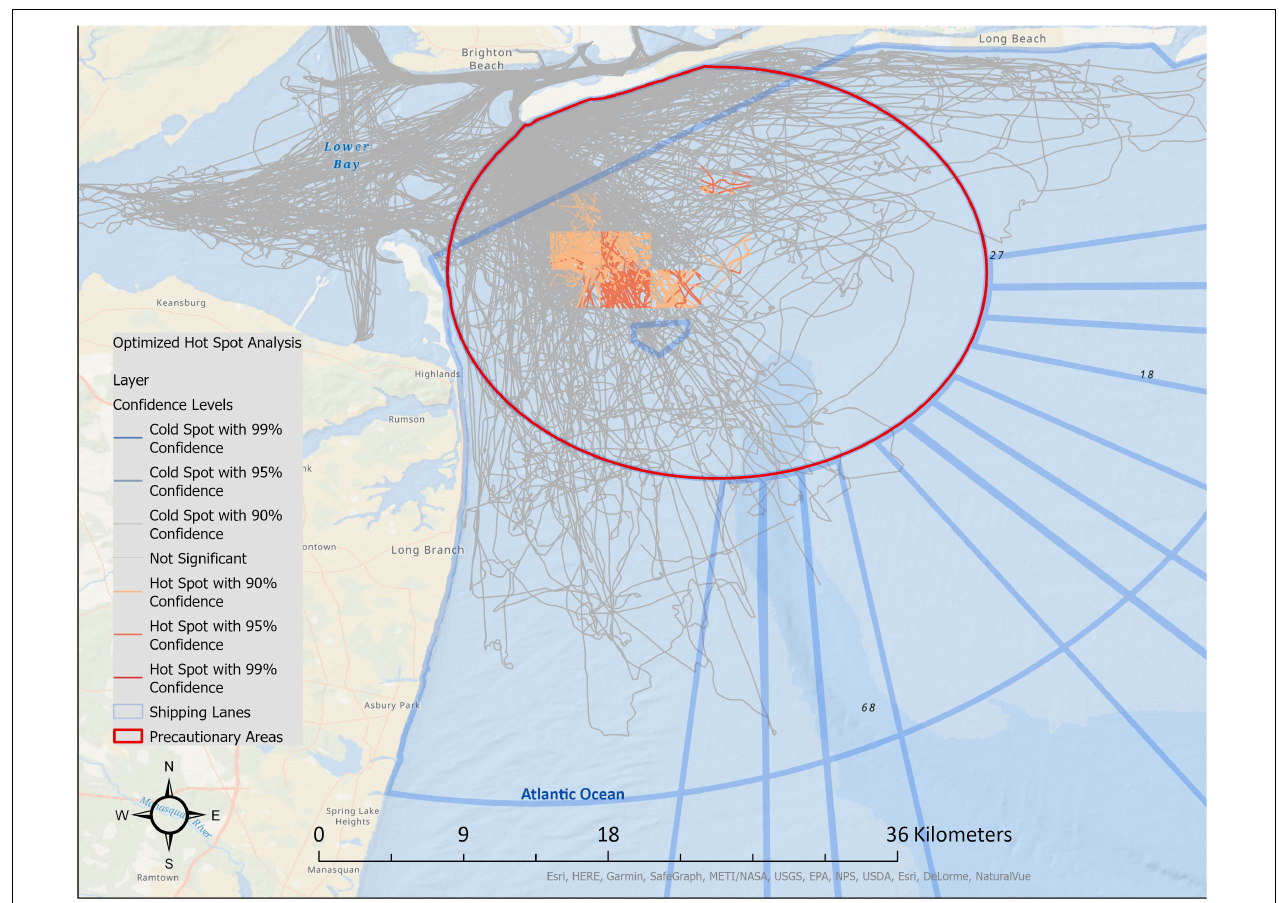
FIGURE 3 | The output from the Getis-Ord Gi* analysis, run through the Optimized Hot Spot tool; with the commercial shipping lanes and precautionary area. The output shows the hot spots according to their confidence levels. Sources : Esri, GEBCO, NOAA, National Geographic, DeLorme, HERE, Geonames.org, and other contributors (Esri, 2022a,b).